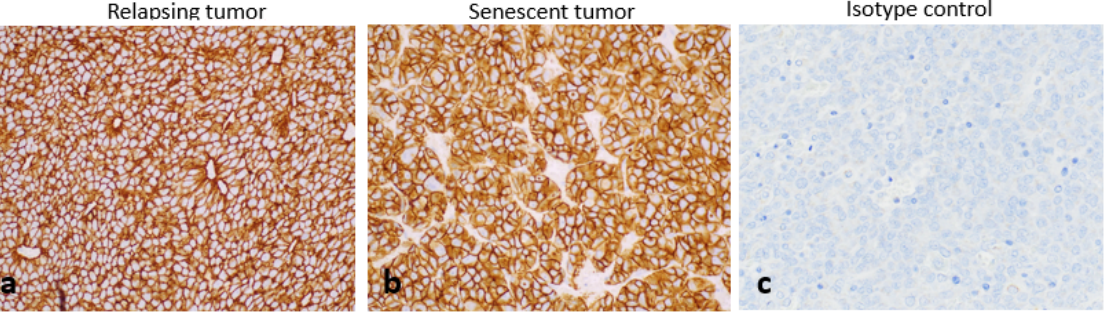
Figure 6. High expression of SST 2 in relapsing tumours ( a ) and senescent tumours ( b ). The isotype control antibody confirmed the specificity of the staining ( c ). All images were taken using the objective 40.